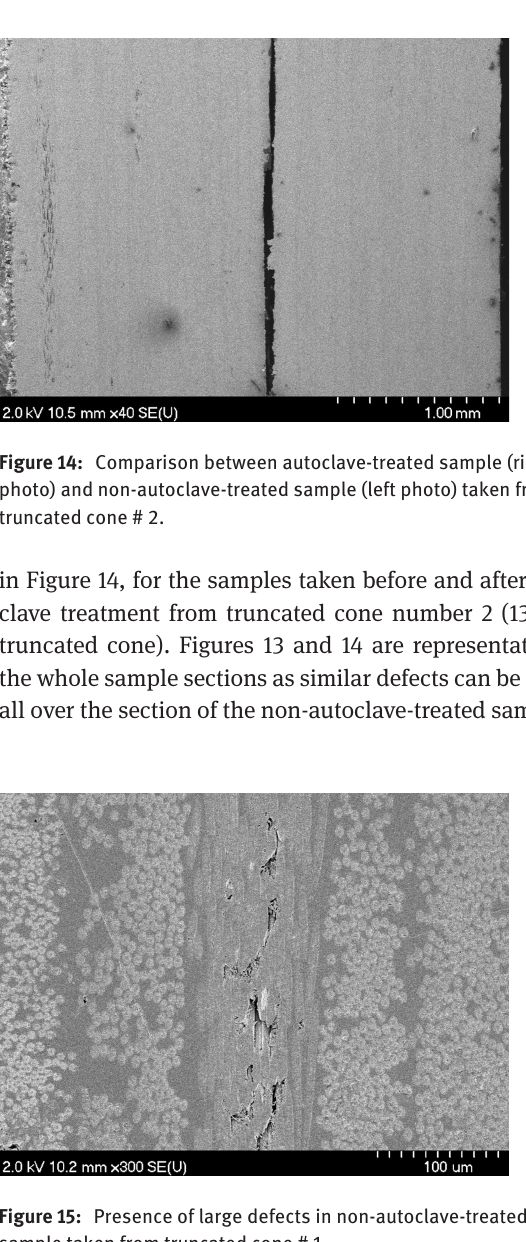
Figure 15: Presence of large defects in non-autoclave-treated sample taken from truncated cone # 1.